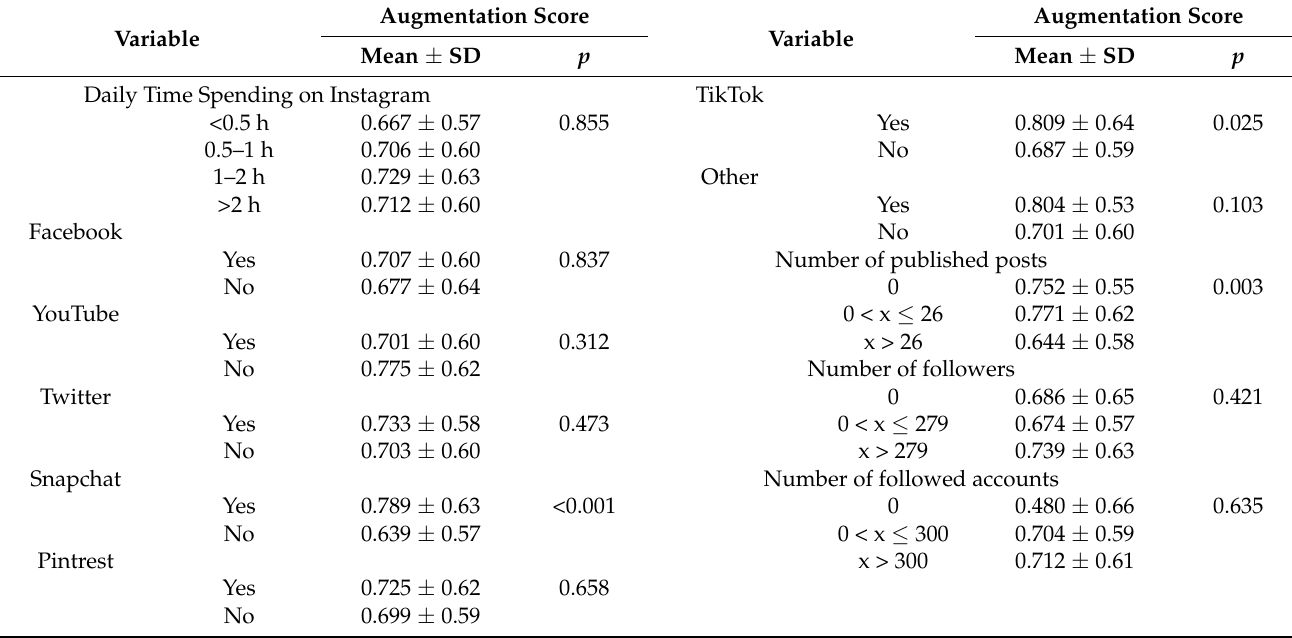
Table 3. Univariate analysis of associations between augmentation scores and other social media platforms use, daily time spent on Instagram and respondents’ activity on this platform ( n = 1050).